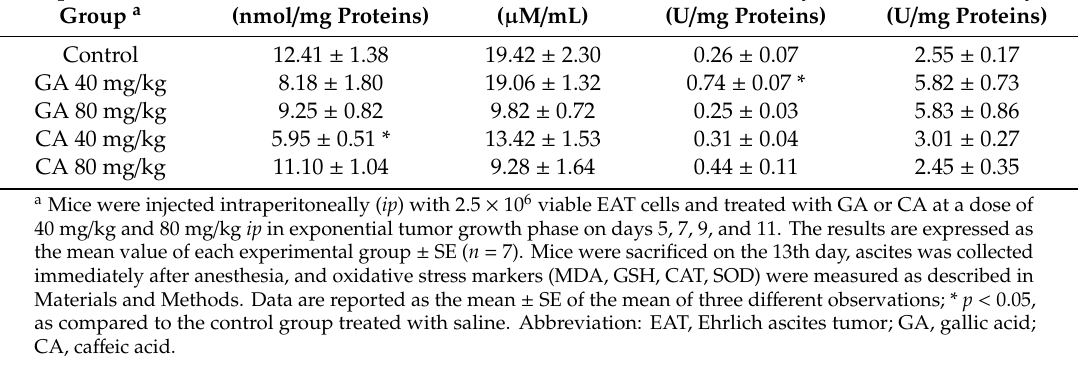
Table 4. E ff ect of GA and CA on oxidative stress markers in the ascites fluid of mice bearing EAT. Experimental